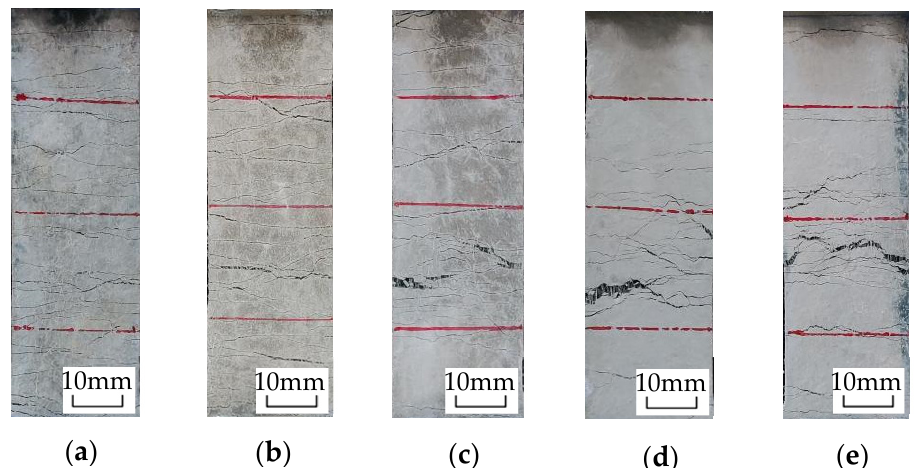
Figure 10. Failure mode of uniaxial tensile specimen: ( a ) Group A; ( b ) Group B; ( c ) Group C; ( d ) Group D; ( e ) Group E.